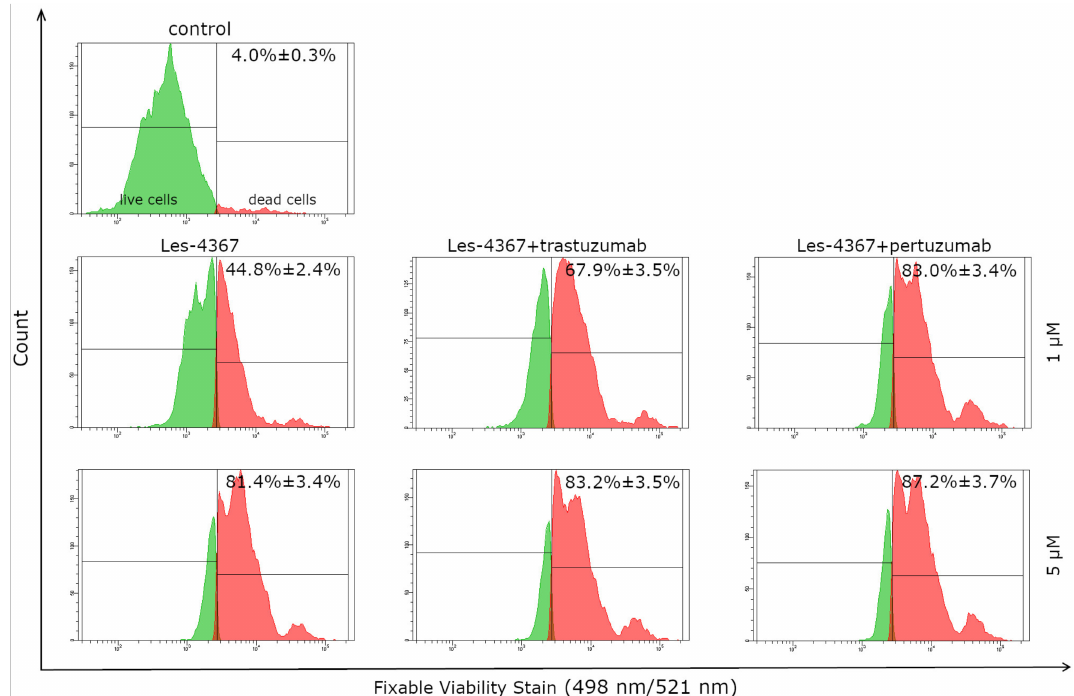
Figure 1. The effect of Les-4367 alone and its combination with trastuzumab or pertuzumab (Les-4367 + trastuzumab, Les-4367 + pertuzumab) on the viability of AGS human gastric cancer cells after 24 h incubation. The numerical value in the upper part of the histogram = the percentage of dead cells. Green part of histogram- live cells, red part of histogram- dead cells. The obtained results are presented as mean values ± SD obtained from three independent experiments (n = 3) performed in